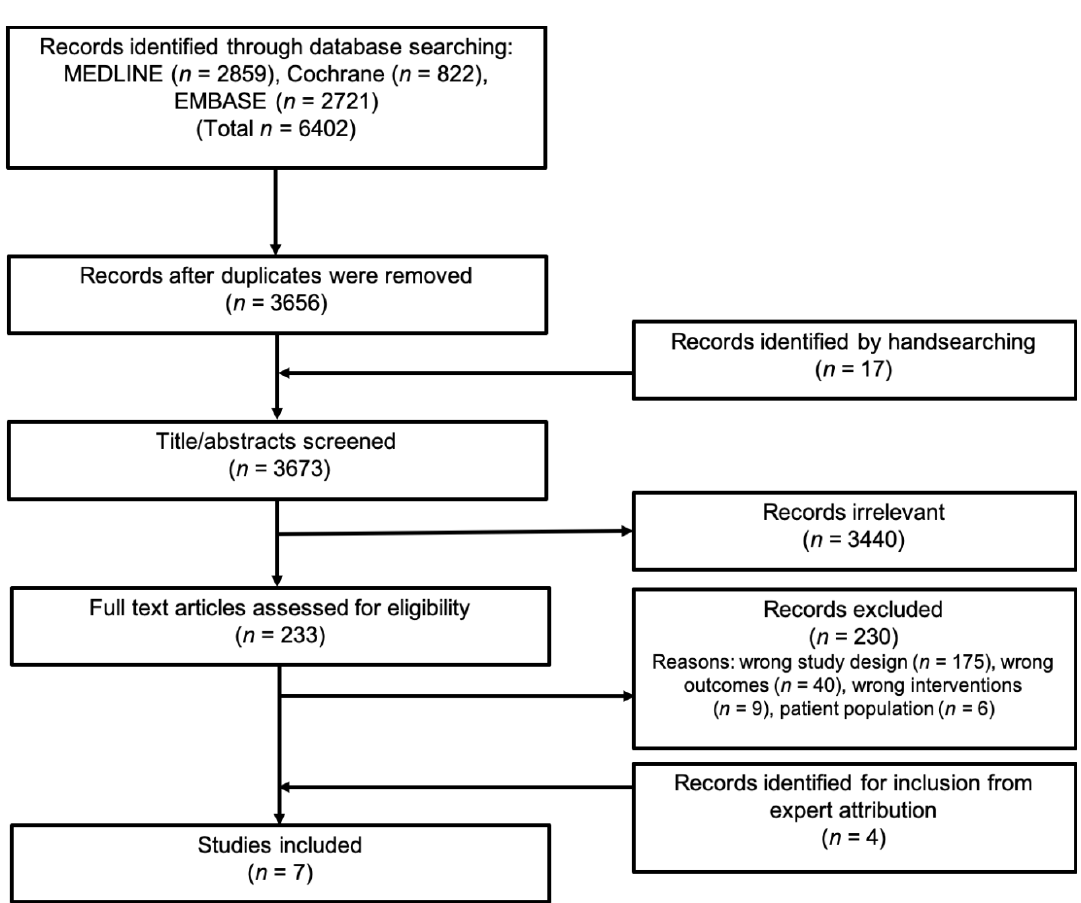
Figure 1. PRISMA flow diagram presenting data from the search and study selection process.